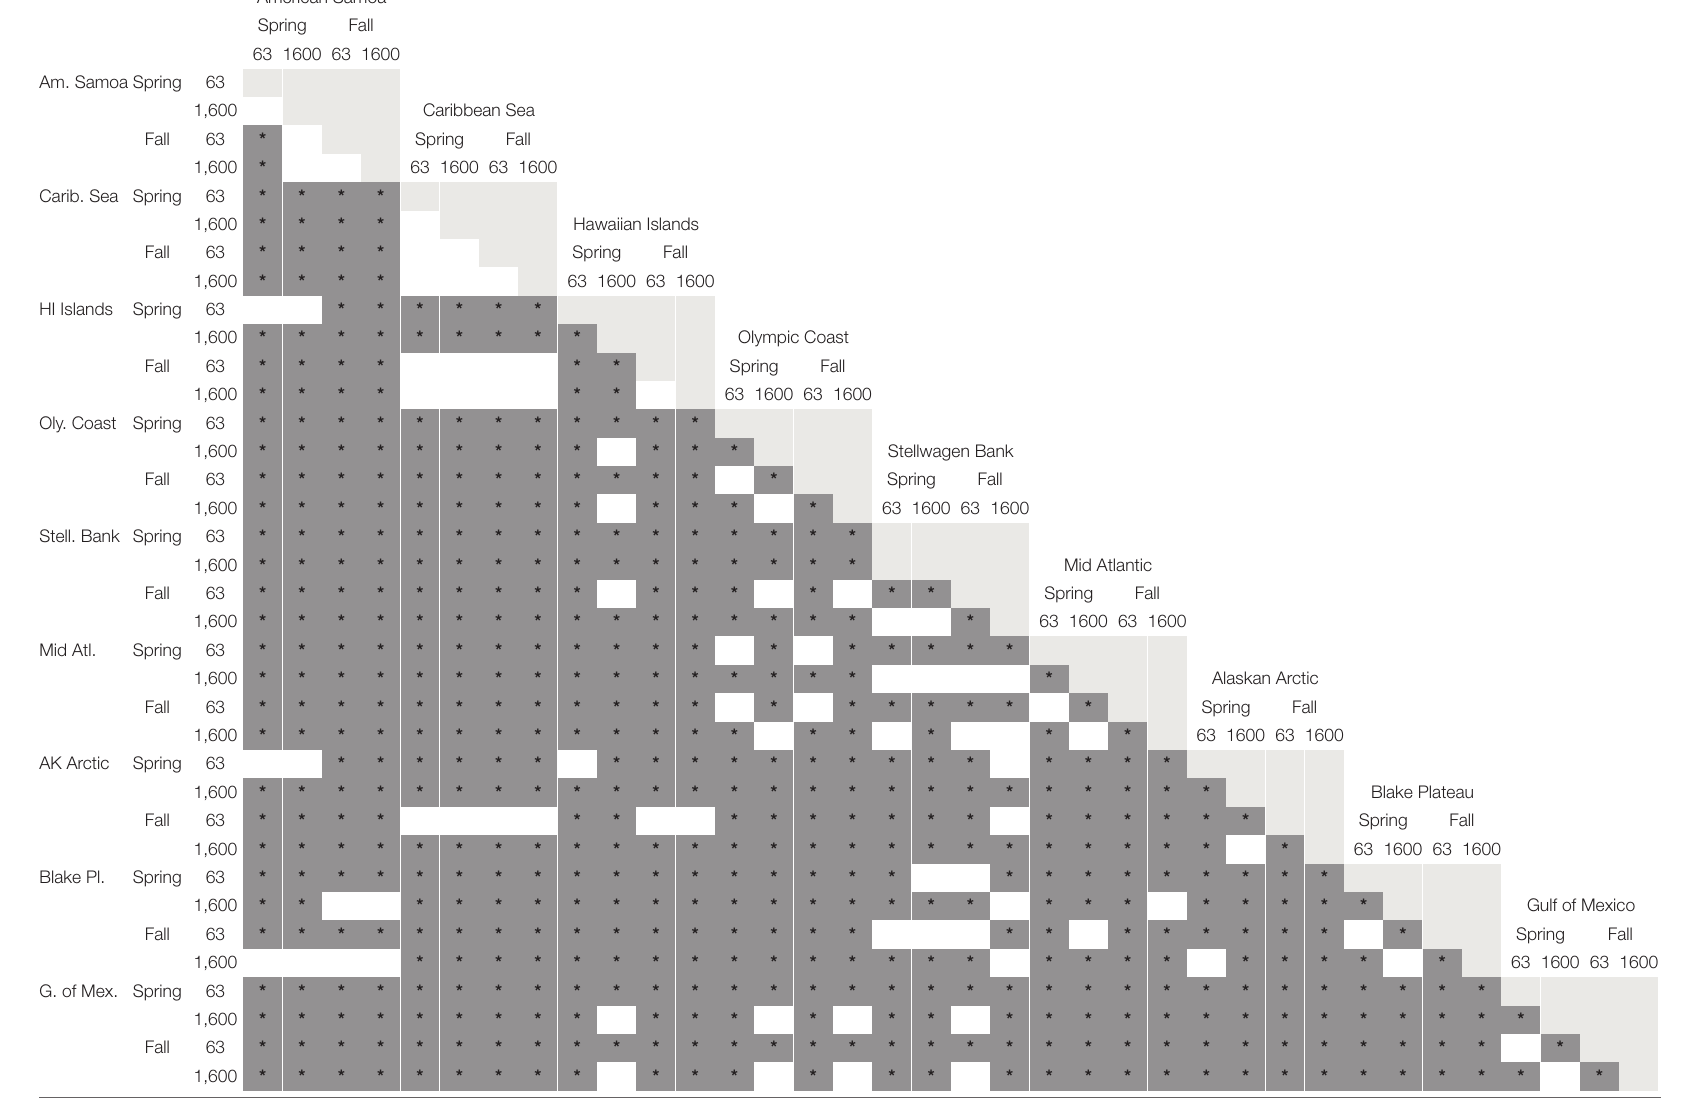
TABLE 3 | Matrix of Tukey HSD results comparing mean SPLs for all sites in the 63 Hz (63) and 1,600 Hz (1,600) decidecade bands recorded in March (Spring) or November (Fall). American